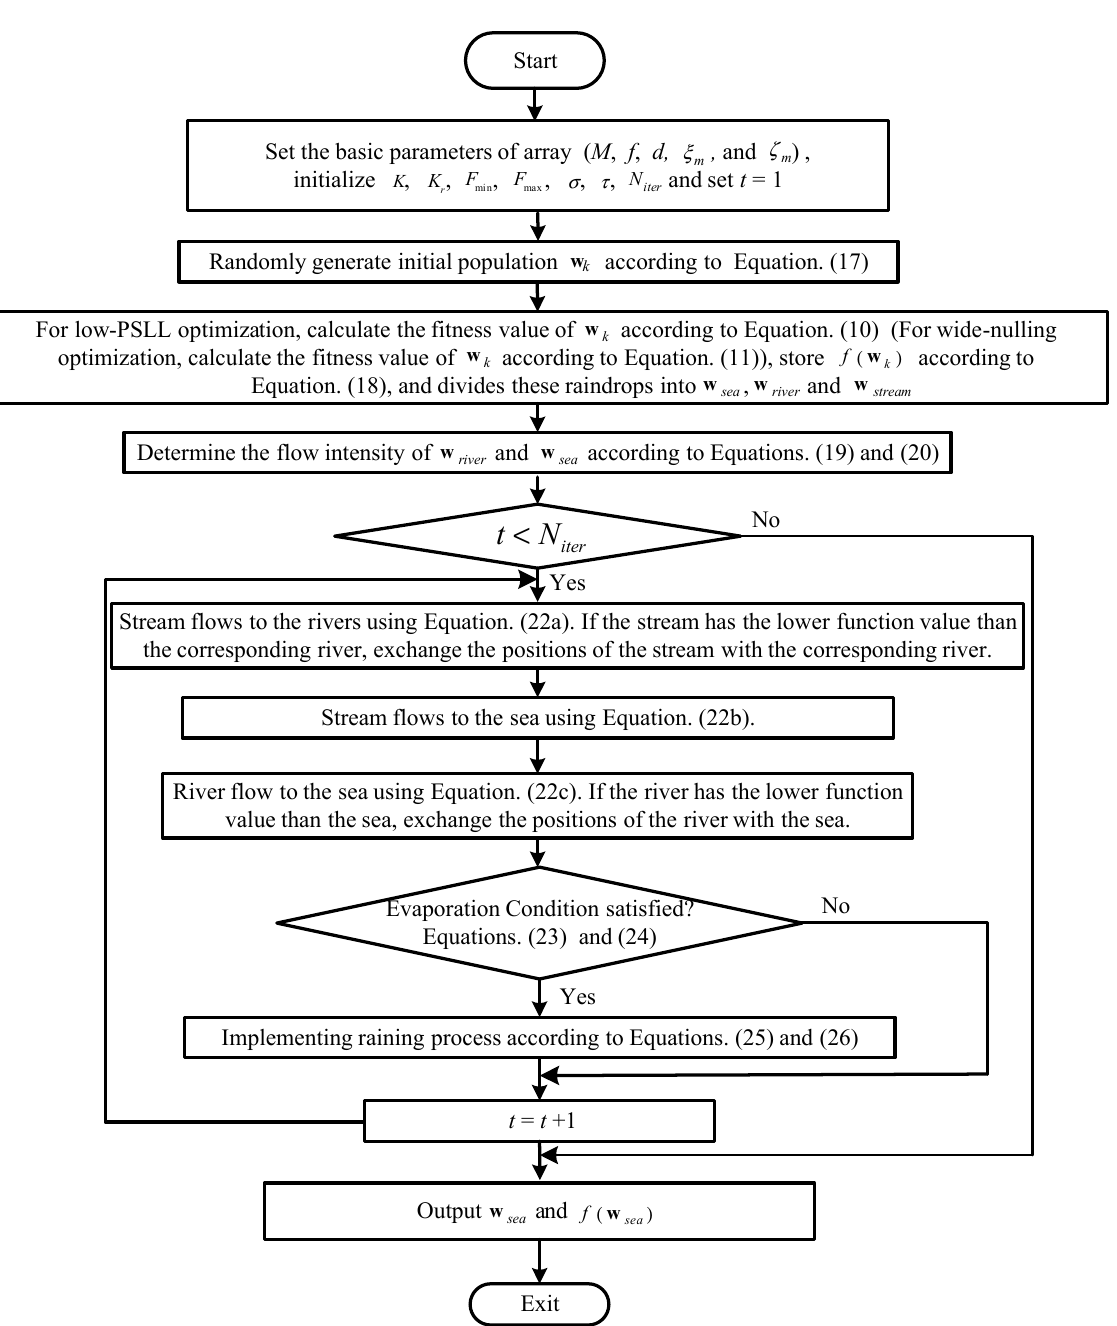
Figure 4. The flowchart of the proposed low PSLL and wide-nulling beampattern synthesis in the presence of array errors based on WCA.